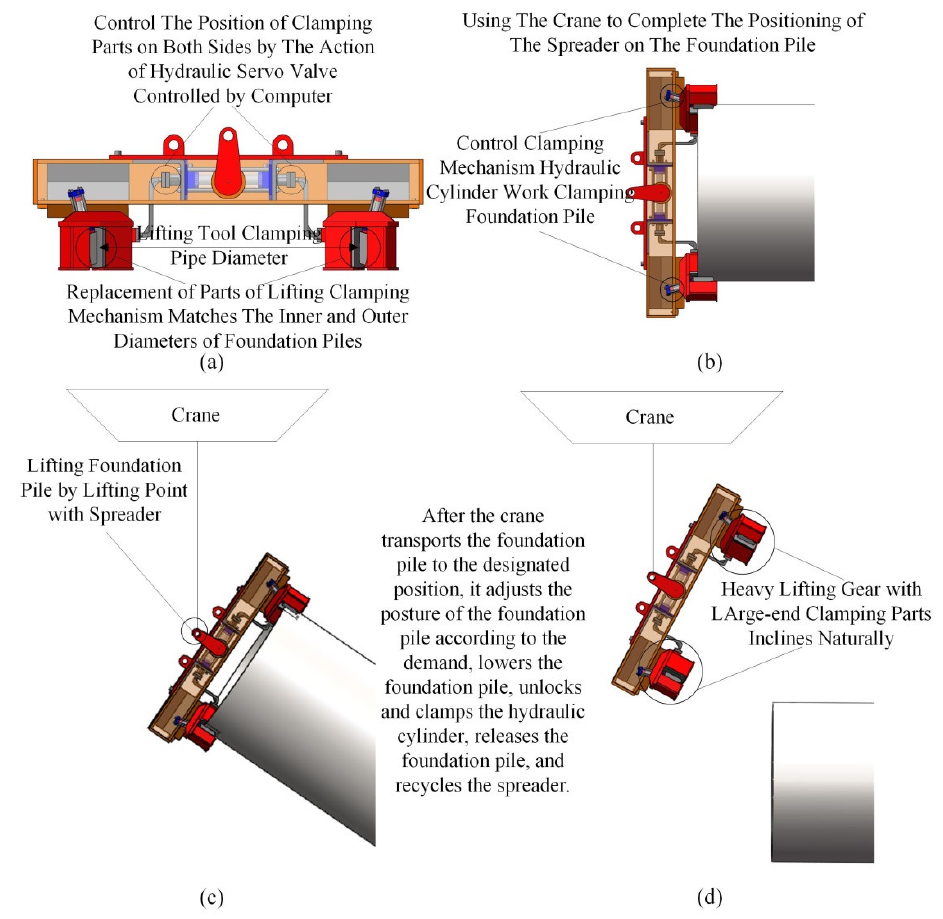
Figure 17. Work Flow of Lifting Foundation Pile by Using the Clamping Type Marine Pile Spreader with Changeable Diameter. ( a ) the lifting device, ( b ) the hanger is installed on the upper part of the pile, ( c ) the hoist lifts the cable, ( d ) the crane lifts, retrieves the lifting.